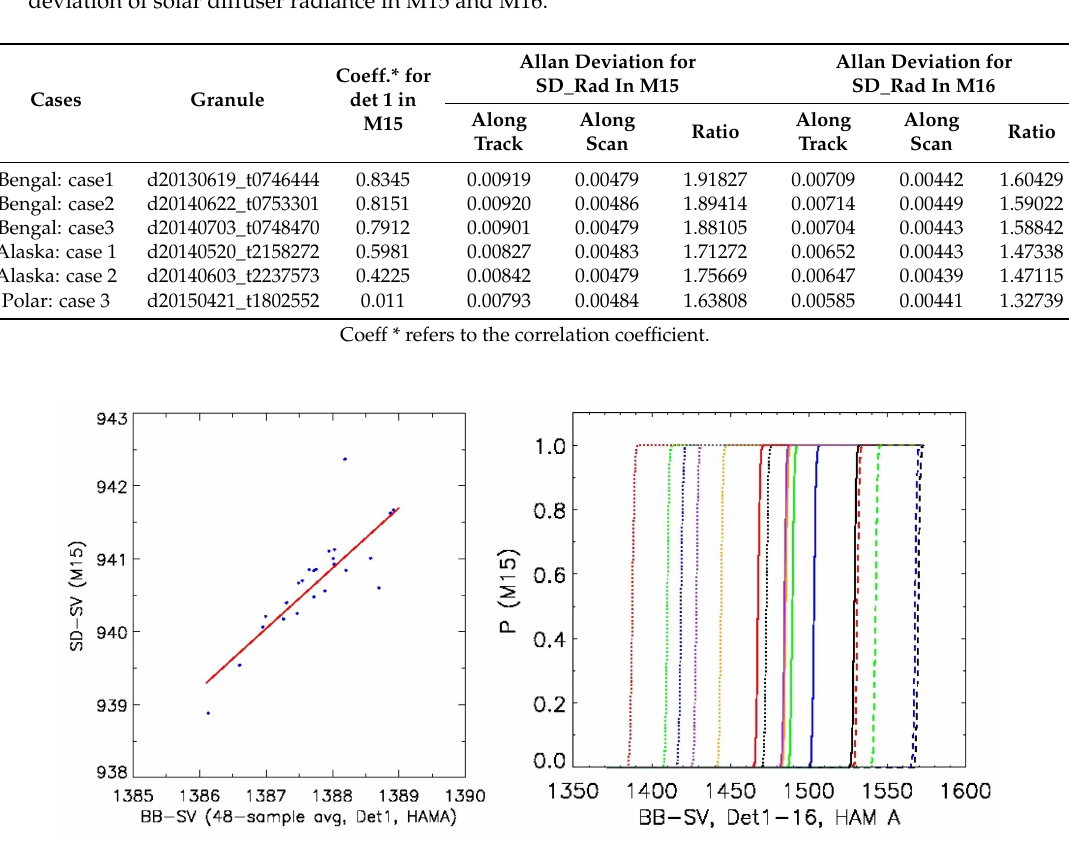
Table 3. Correlation coefficients between dBB and dSD, as well as along track and along scan Allan deviation of solar diffuser radiance in M15 and M16.